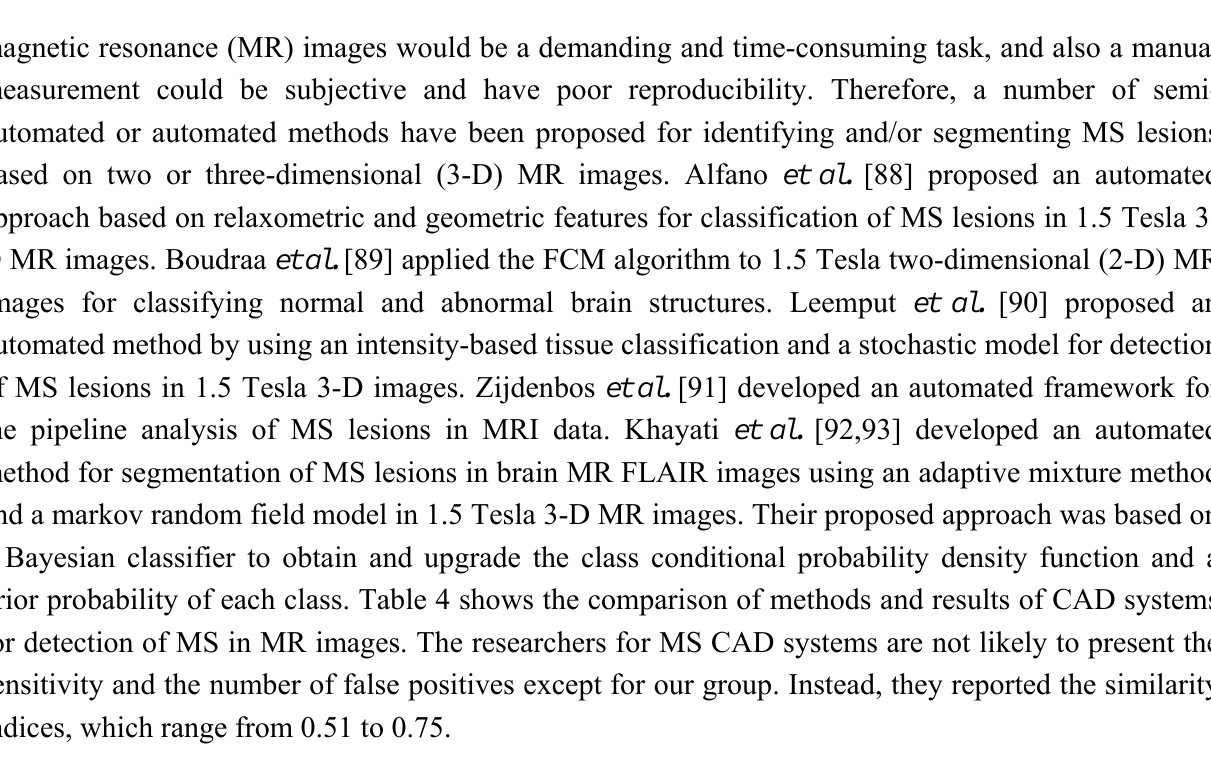
Table 4. Comparison of methods and performance of CAD systems for detection of MS in MR